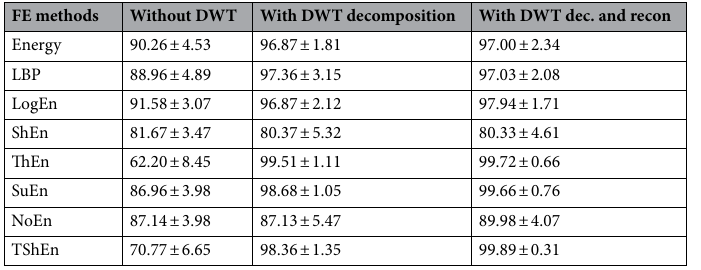
Table 4. Classification accuracy of off-PD versus HC using KNN classifier with 10 × tenfold